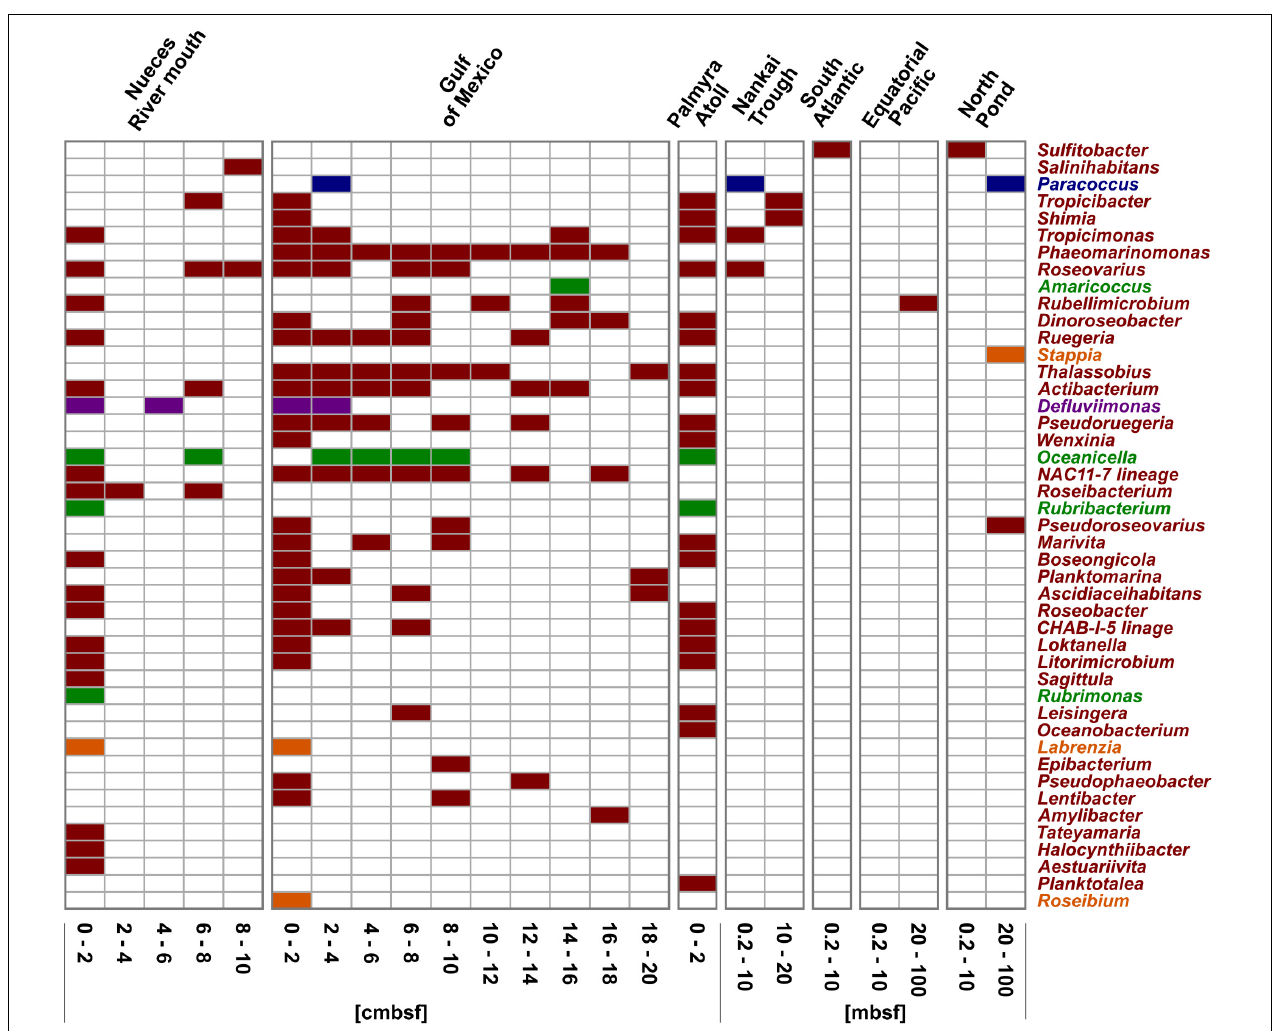
FIGURE 5 | Distribution of the OTUs affiliated to cultured representatives within the Rhodobacteraceae . OTUs are sorted by their relative abundance on the total bacterial community. Sample locations are arranged by water depth and then by sediment depth. The affiliation of OTUs to the phylogenetic subgroups is displayed by red = Roseobacter , orange = Stappia , green = Amaricoccus , purple = Rhodobacter, and blue = Paracoccus